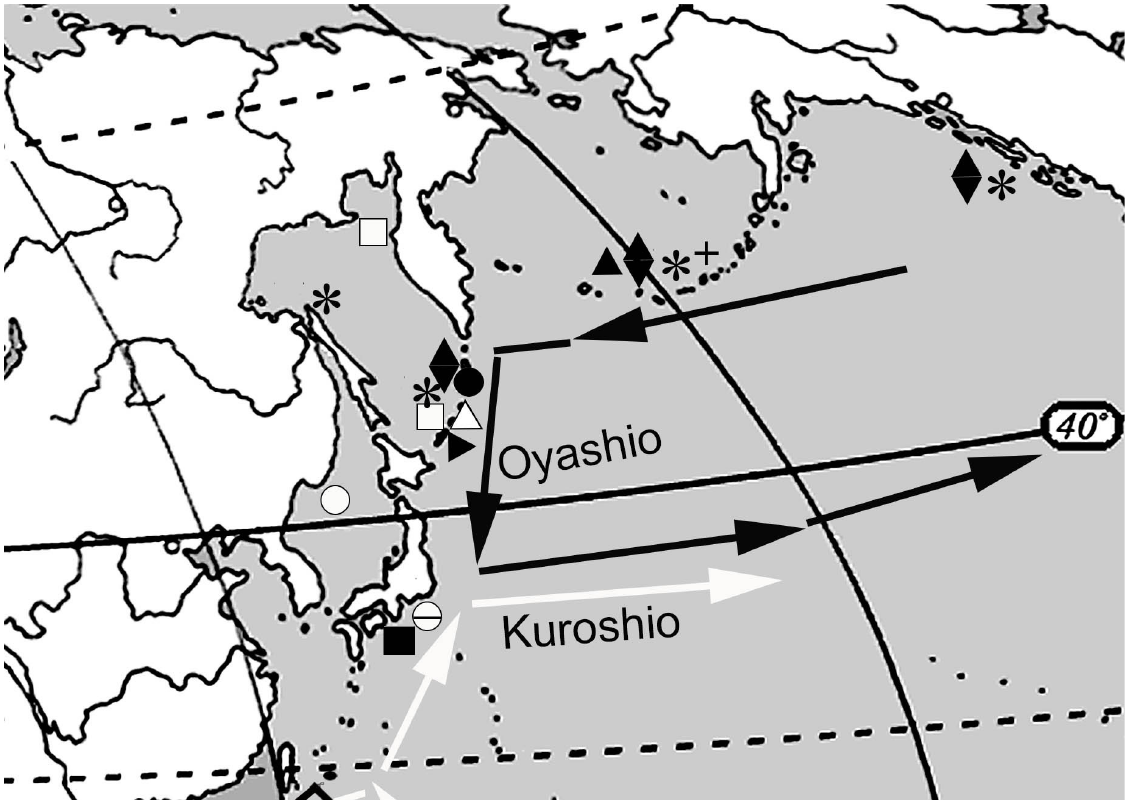
Fig. 13. Map of the distribution of the Calcigorgia gorgonians. The regions of Calcigorgia species collection (based on the literature and data in the present paper, see explanation in the text) are marked: ► = C. beringi; + = C. gigantea; Ө = C. gracilis ; ● = C. herba sp. nov.; ○ = С. japonica; □ = C. lukini sp. nov.; ∆ = C. matua ; ▀ = C. pacifica ; ▲ = C. simushiri ; * = C. spiculifera ; ♦ = Calcigorgia sp. Black arrows indicate the direction of the Alaskan Stream and Oyashio Current; white arrows show the direction of the Kuroshio